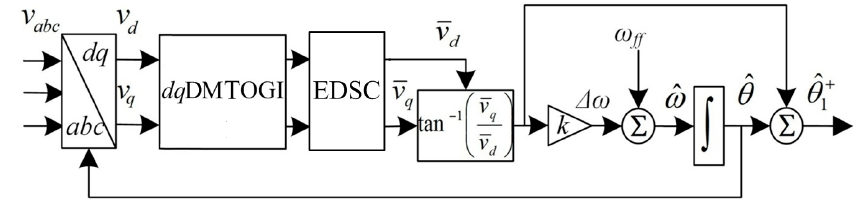
Figure 10. Block diagram of the proposed PLL in this paper.